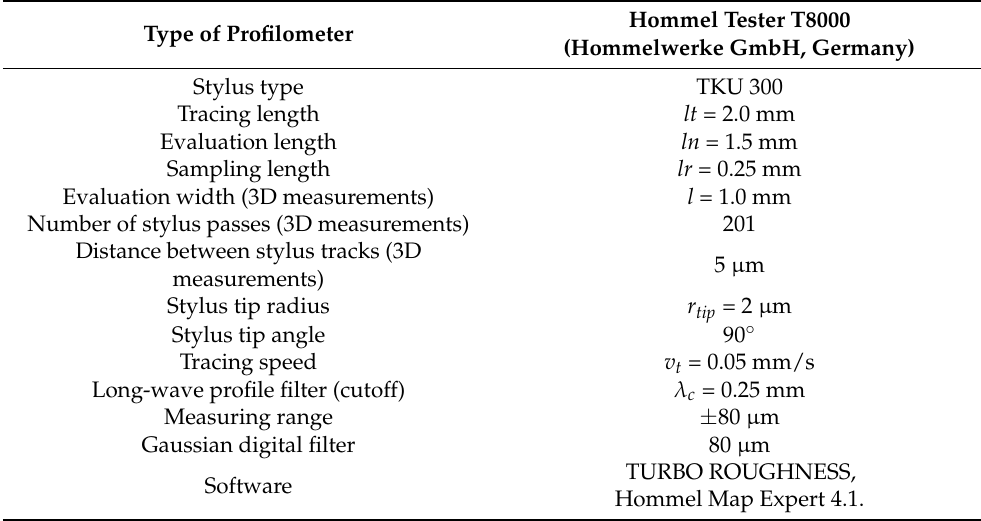
Table 1. Surface roughness measuring